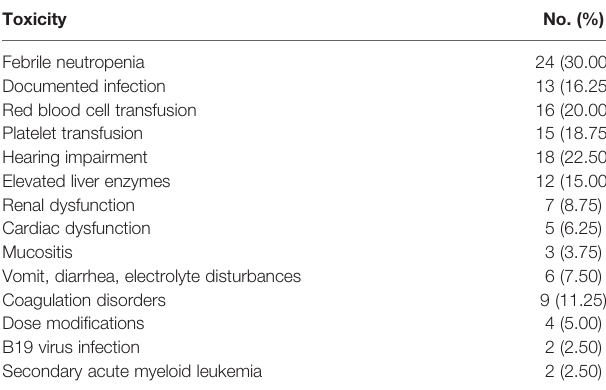
TABLE 5 | Treatment-related toxicities after induction therapy. TABLE 4 | Induction treatment response after four- and eight-cycle